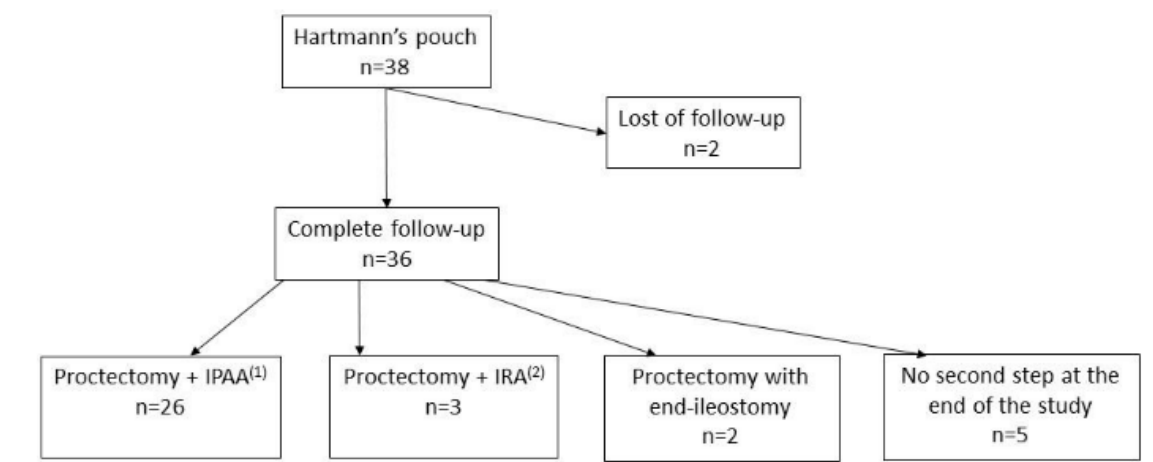
Figure 1. Flowchart. (1) Ileal J-pouch anal anastomosis. (2) Ileorectal anastomosis. Proctectomy with IPAA was performed by laparoscopy in 17 patients (65.4%) and by laparotomy in 9 patients (34.6%). Four patients had previously had laparotomy for subtotal colectomy, and five patients underwent a conversion to the open approach because of adhesions.